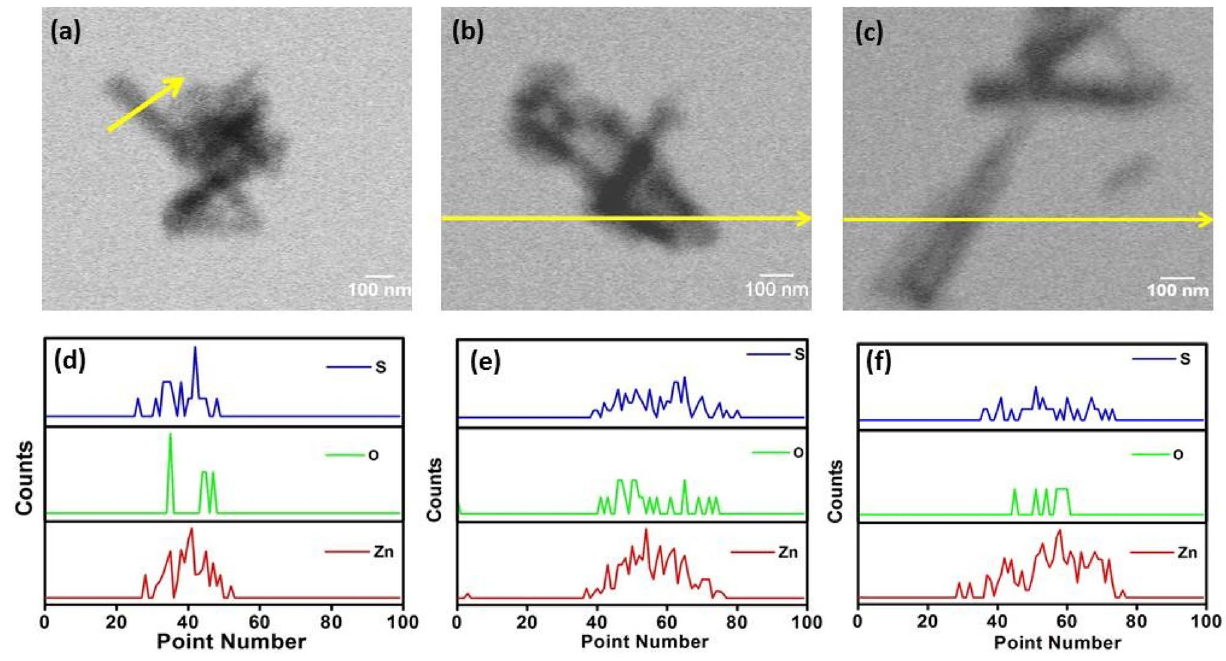
Fig. 3 STEM micrographs and their corresponding line mapping a, d Z3, b, e Z4 and c, f Z5